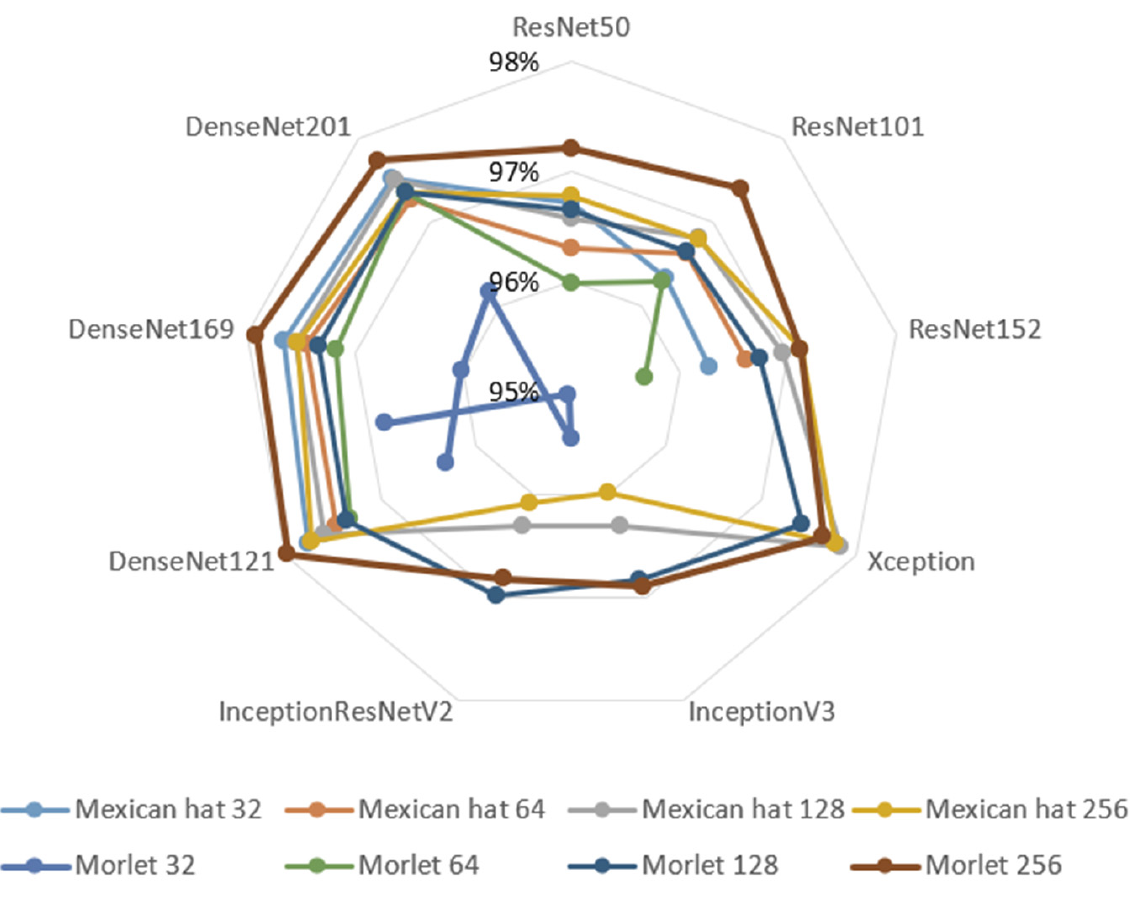
Figure 7. A radar chart with the classification results obtained during the model selection.